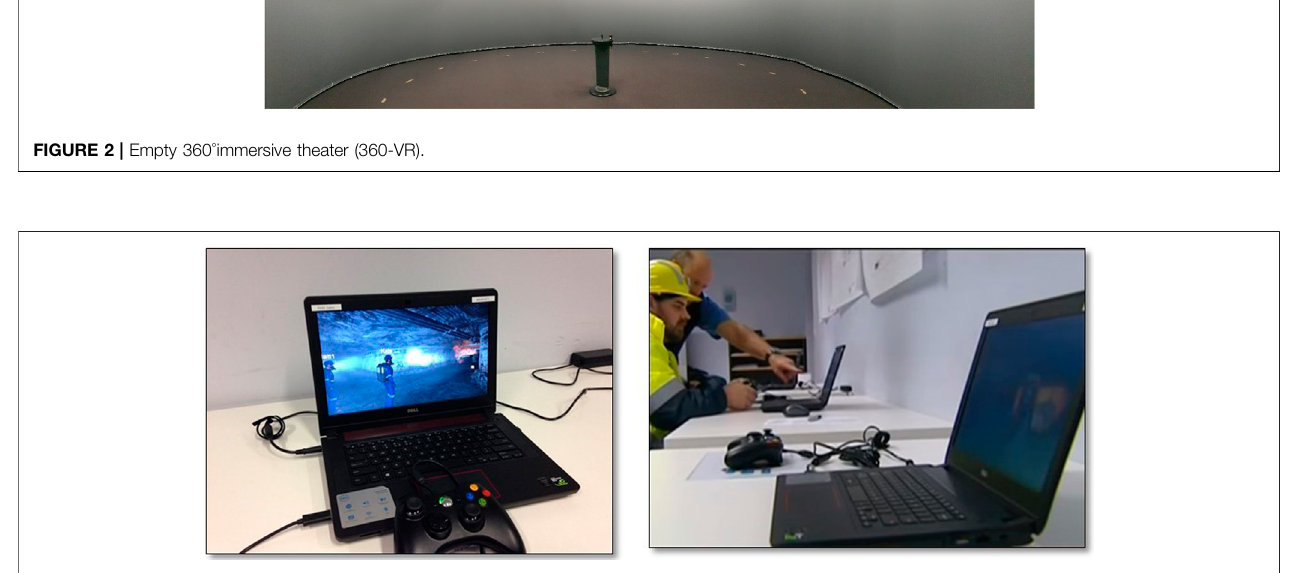
FIGURE 3 | Desktop-VR setup with gamepad.